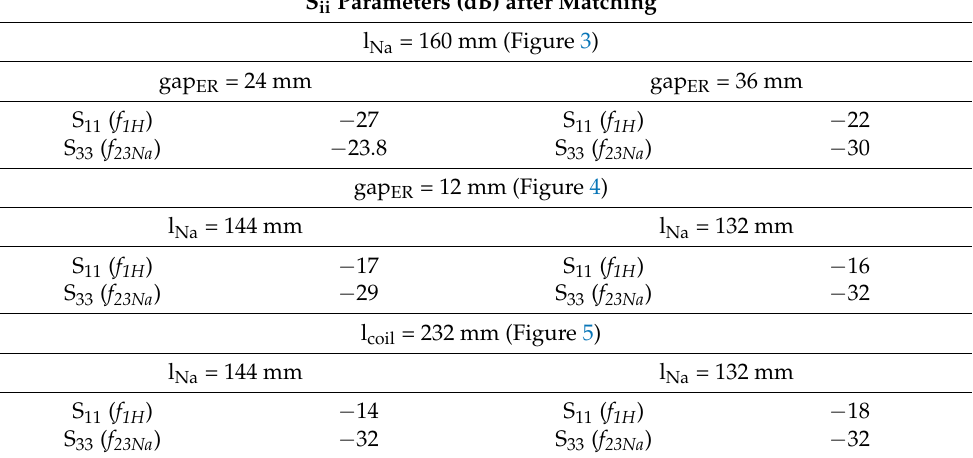
Table 2 . Simulated scattering parameters (S ii ) of the four-ring DT-RF coil models after matching. Port 1 refers to the first proton port; the reflection coefficient of the second proton port, S 22 , is equal to S 11 . Port 3 refers to the first sodium port; the reflection coefficient of the second sodium port, S 44 , is equal to S 33 .